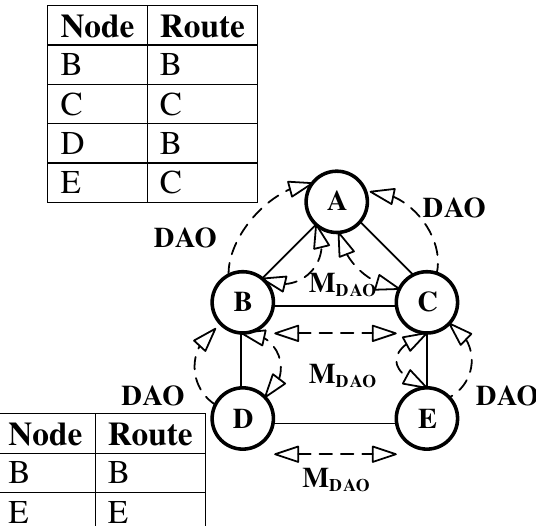
Figure 2. Point to Multi-Point (P2MP) and Peer-to-Peer (P2P) Routing Using Multicast Destination Advertisement Object